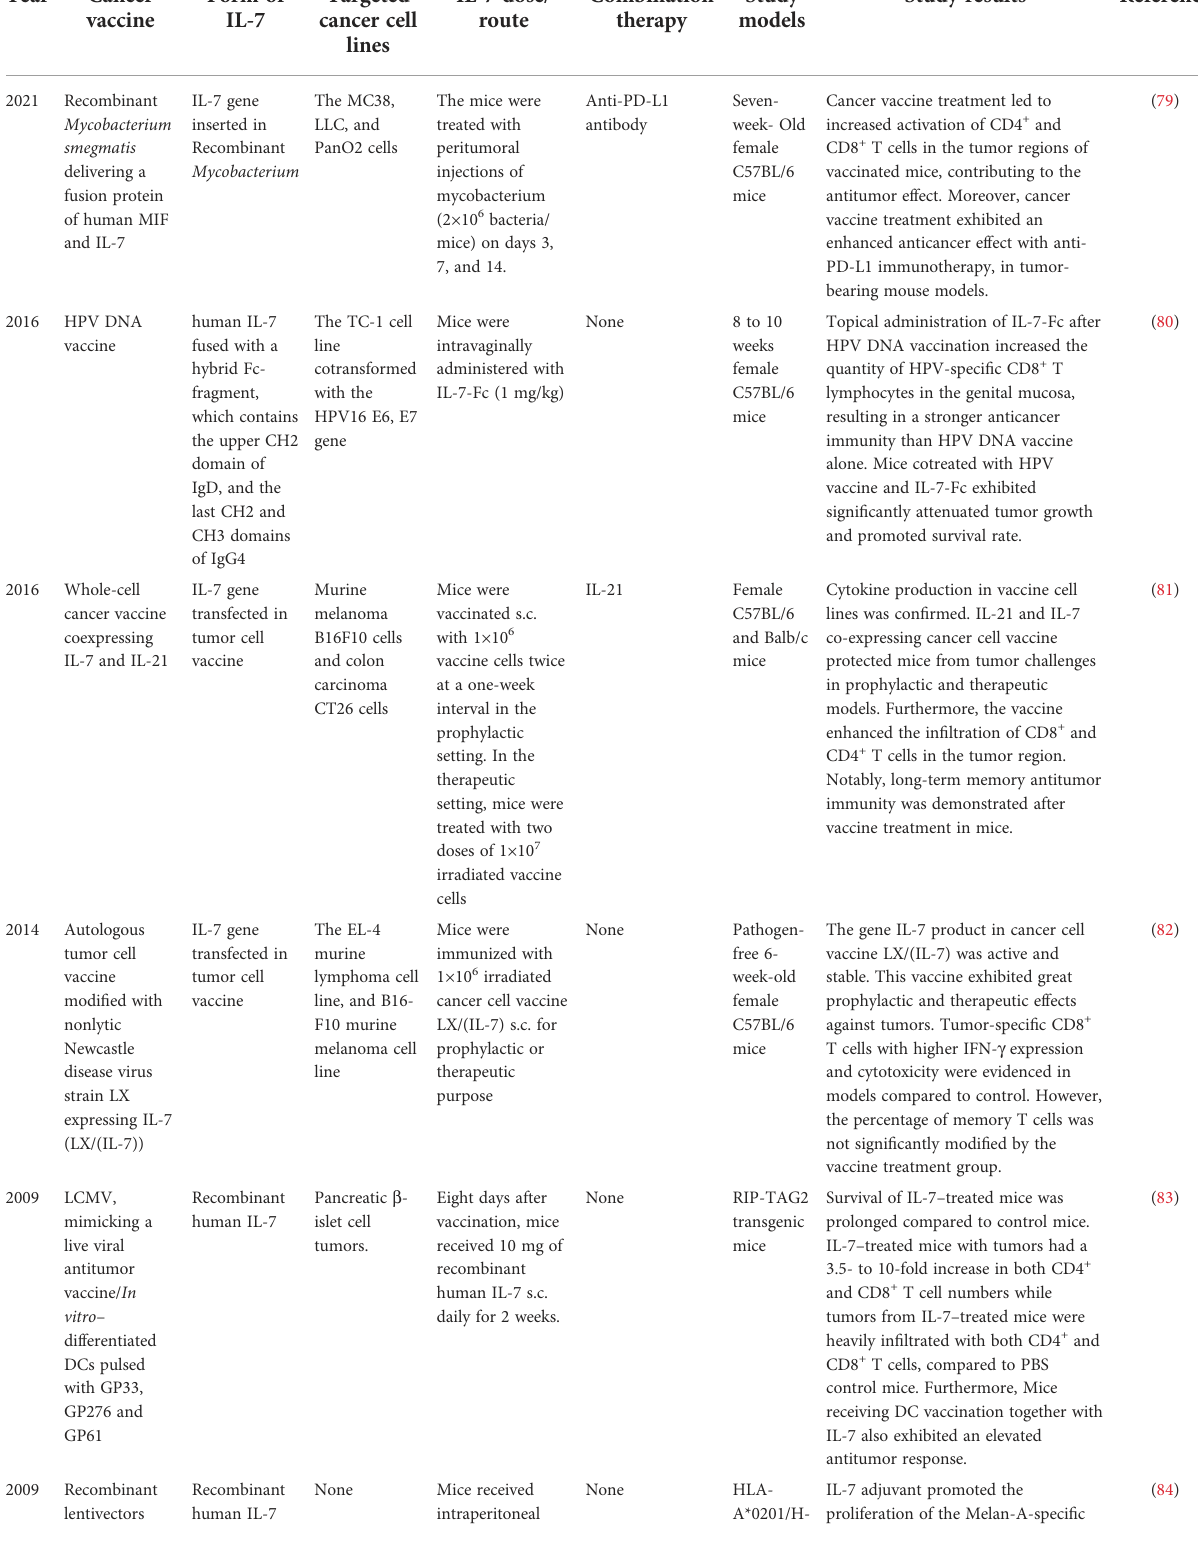
TABLE 1 Adjuvant effect of IL-7 in cancer vaccine treatment summarized from selective preclinical